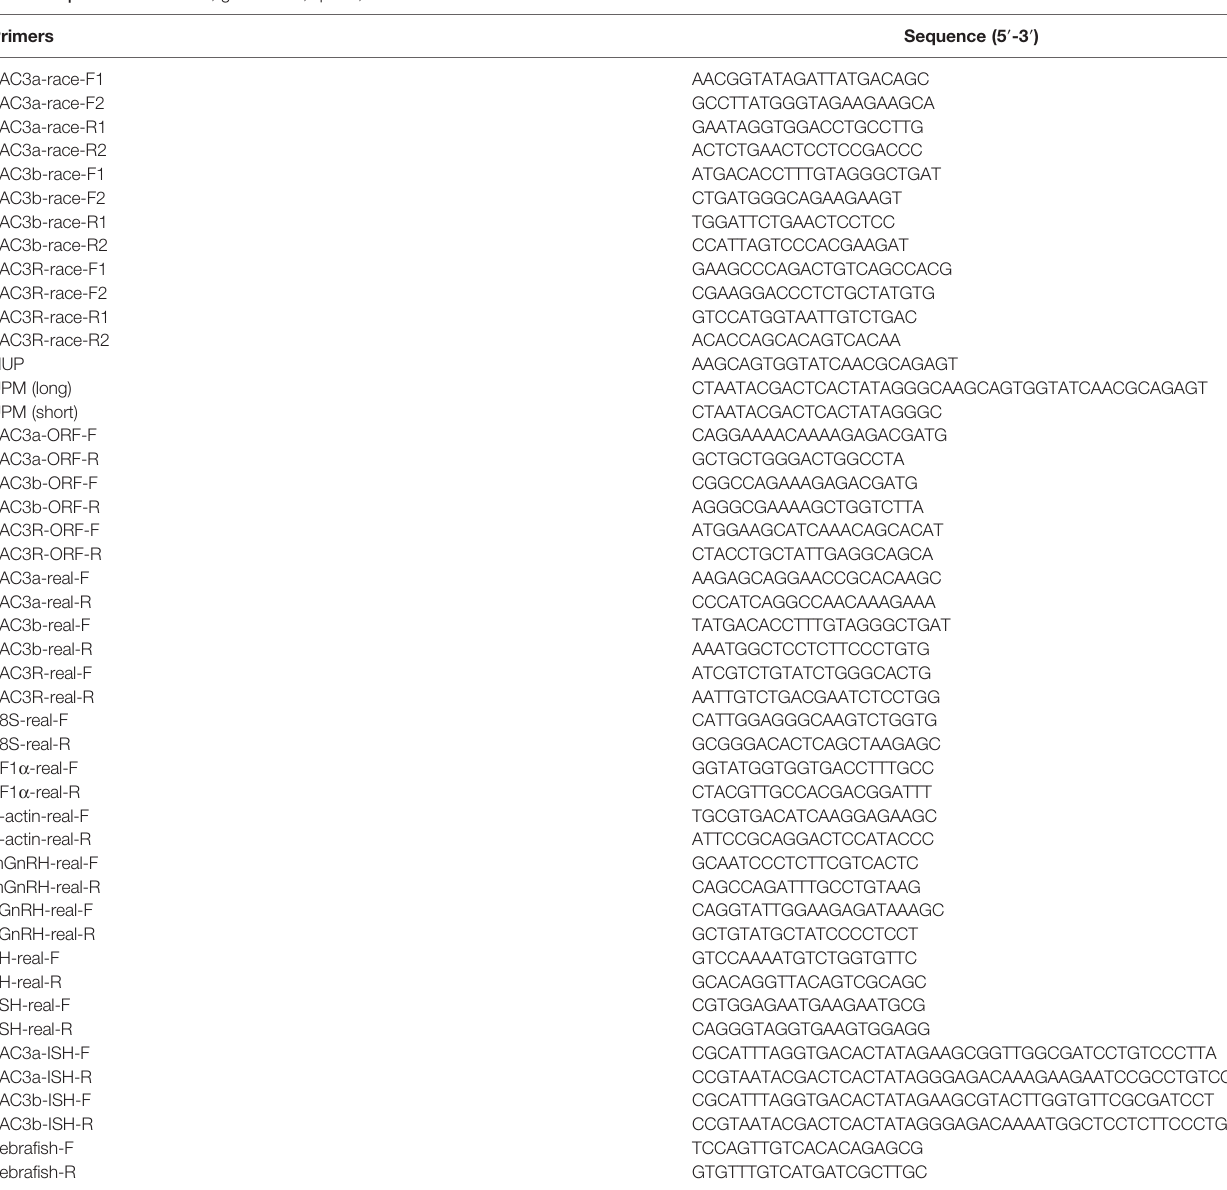
TABLE 1 | Primers for RACE, gene clone, qPCR, and